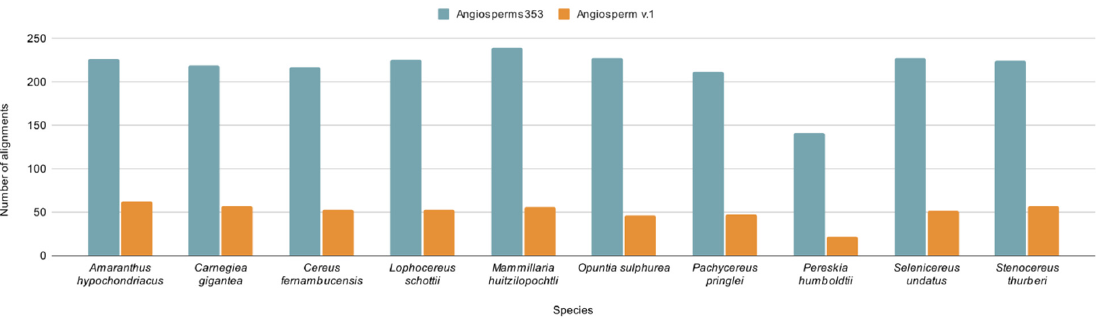
Angiosperms353 varied from 0.4% ( C. fernambucensis ) to 6.7% ( M. huitzilopochtli ). The orthologous loci identified in 70% of the analyzed species totaled 240 alignments with Angiosperms353, and only 71 alignments were obtained with Angiosperm v.1. The lowest number of alignments was obtained for the species P. humboldtii : 141 and 22 align- ments obtained with Angiosperms353 and Angiosperm v.1, respectively. In contrast, the highest number of alignments was obtained for A. hypochondriacus (62) and M. huitzilopochtli (239) with Angiosperm v.1 and Angiosperms353, respectively (Figure 2).